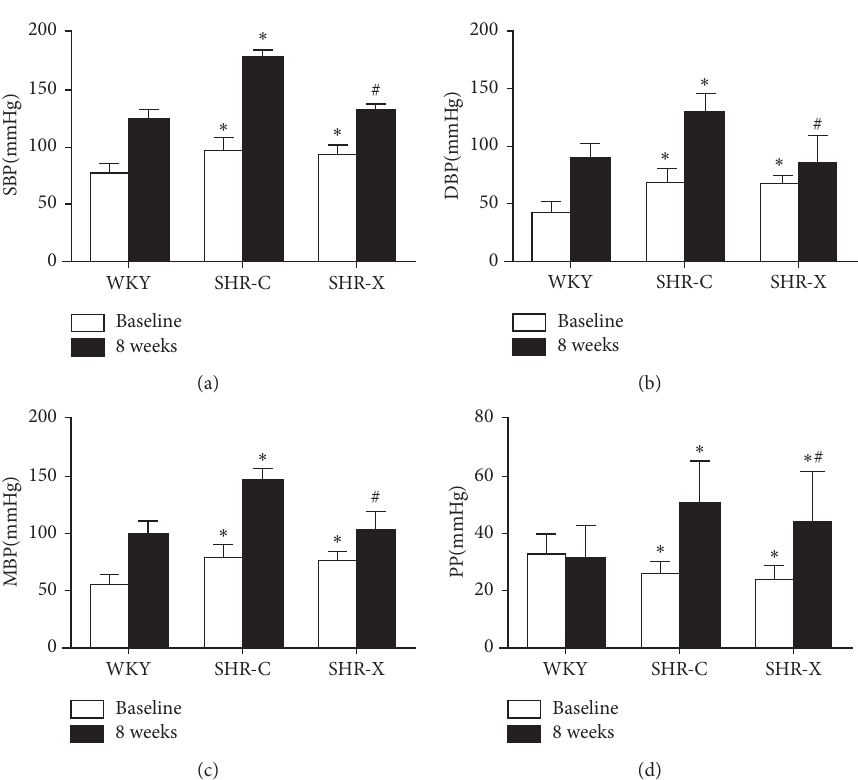
Figure 1: The effect of Xinmaitong on the blood pressure. Values are means ± SD. WKY: Wistar-Kyoto rats; SHR: spontaneously hy- pertensive rats; SHR-C: SHR control; SHR-X: SHR Xinmaitong treatment. ∗ P < 0 . 05 versus WKY. # P < 0 . 05 versus SHR-C.